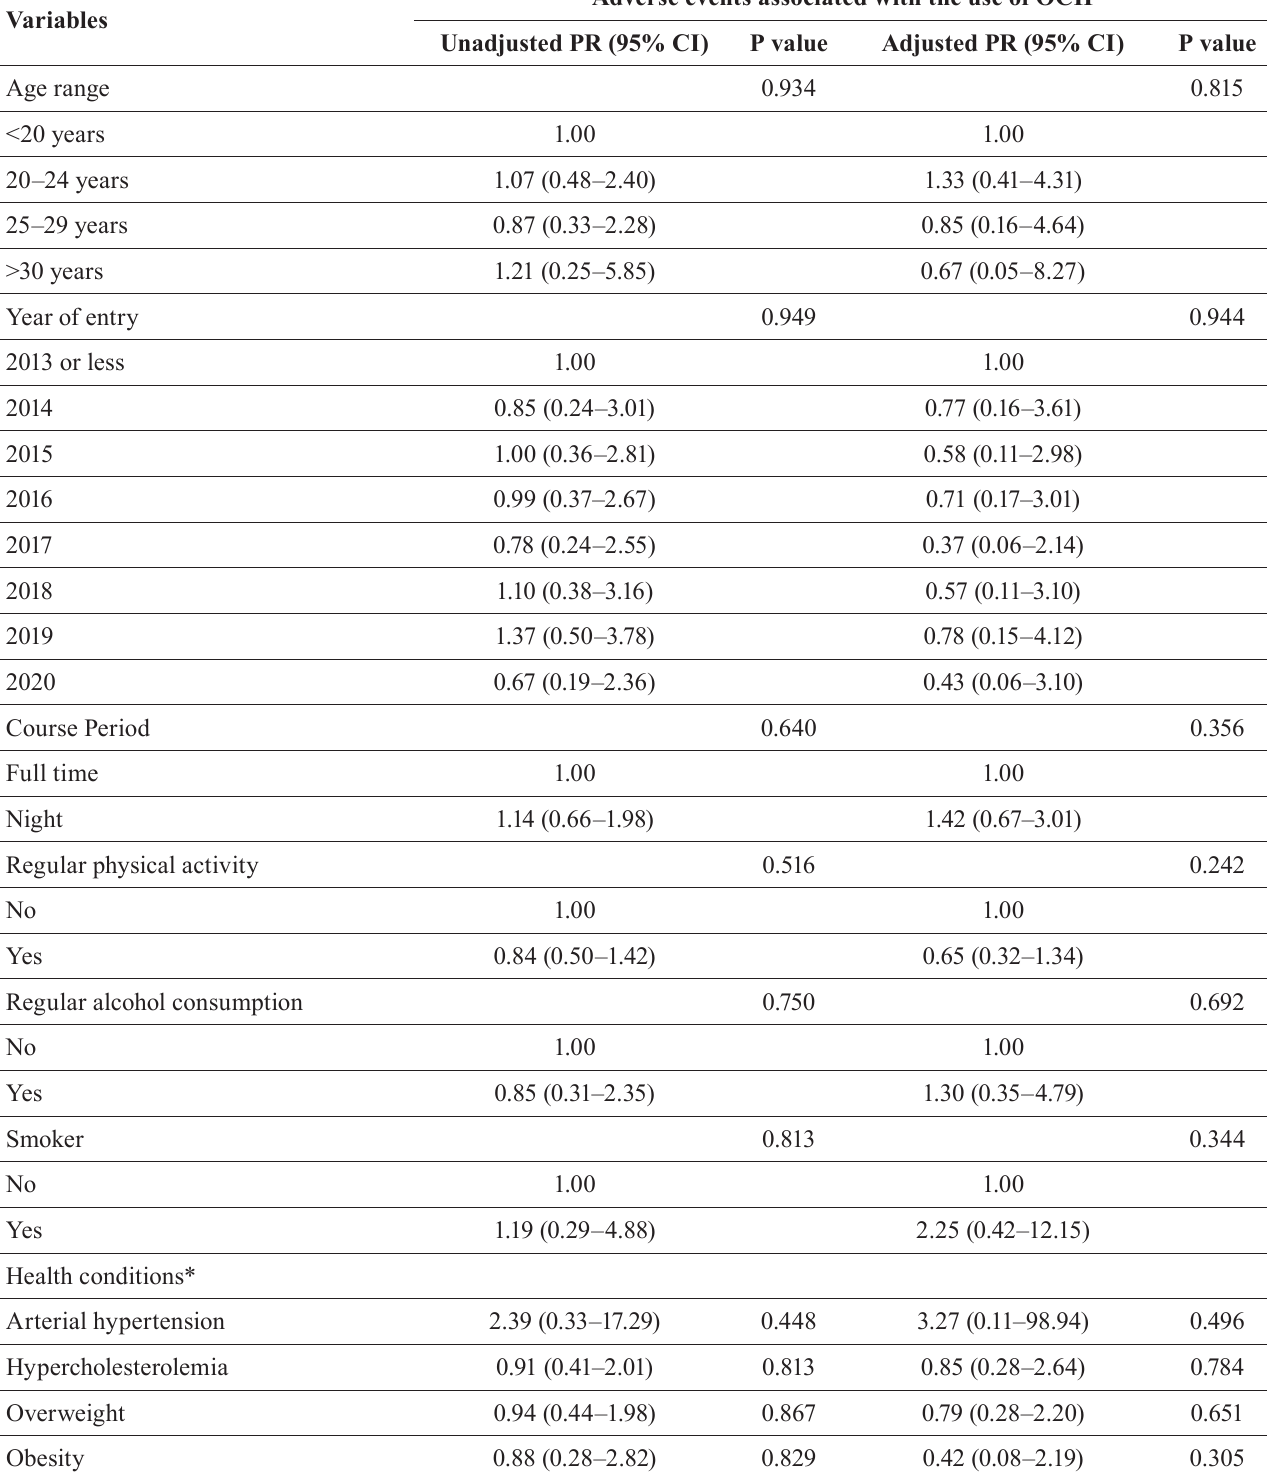
TABLE V - U nadjusted and adjusted prevalence ratios (PR) with 95% confidence intervals (95% CI) for the occurrence of adverse events among pharmacy students who used oral hormonal contraceptives (n = 135)